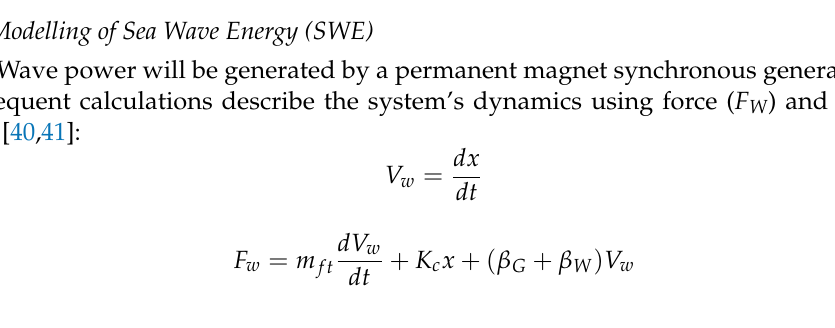
Figure 2. Wind turbine in a Marine Microgrid system.